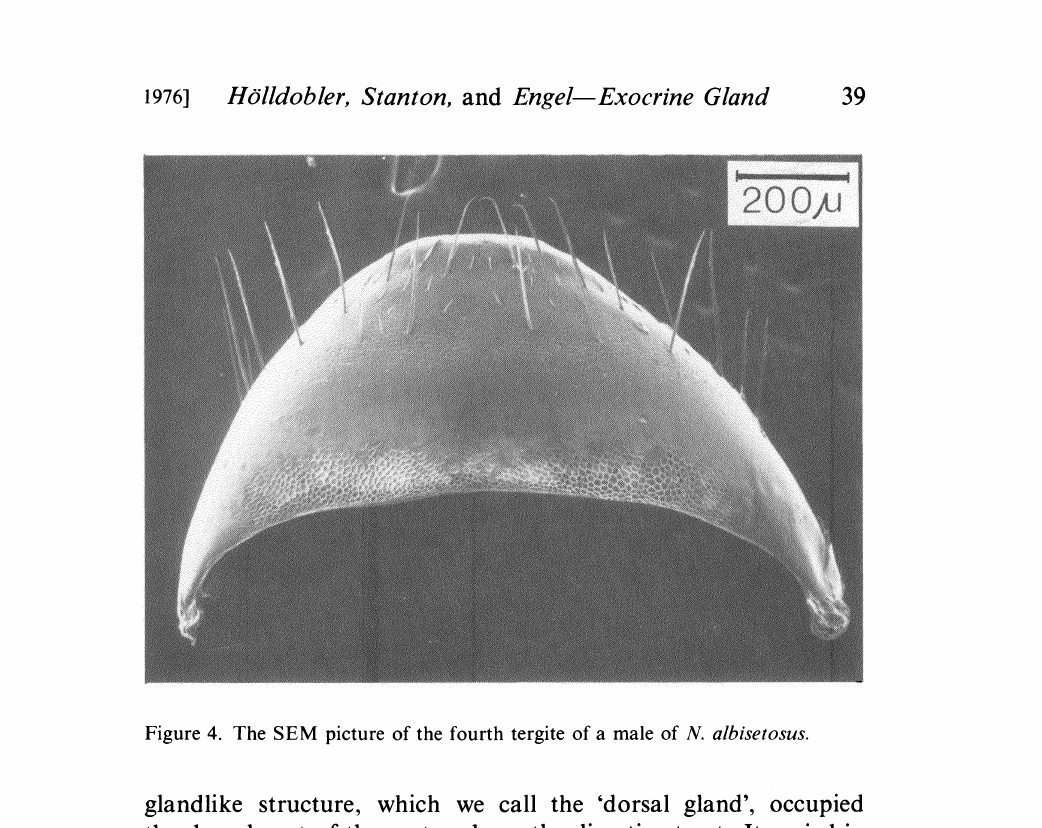
Figure 4. The SEM picture of the fourth tergite of a male of N.